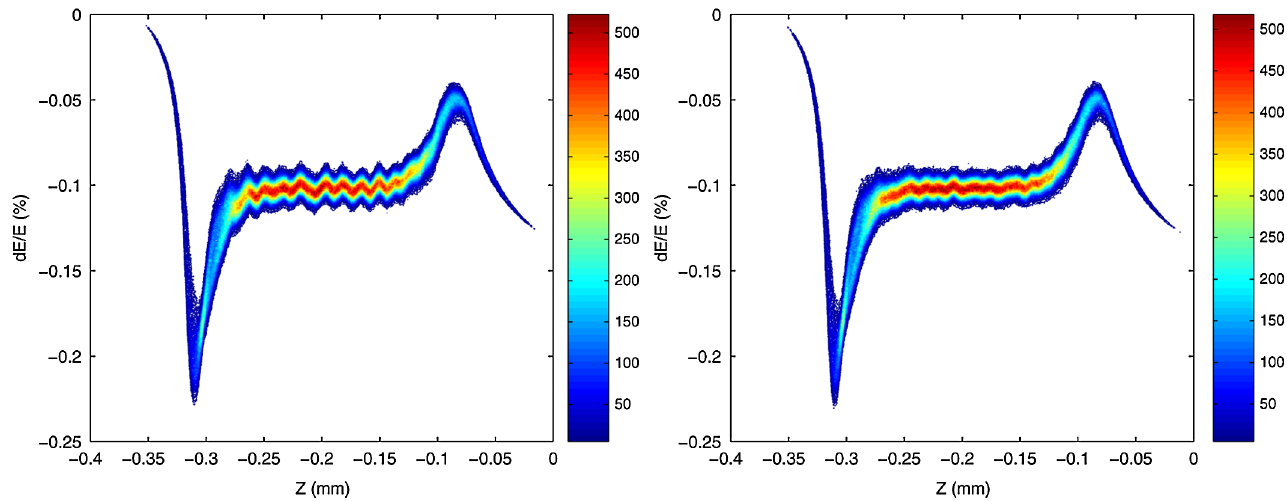
FIG. 11. (Color) Longitudinal phase space at the end of the linac using one billion (left) and five billion macroparticles (right) with an initial 5 keV rms uncorrelated energy spread.